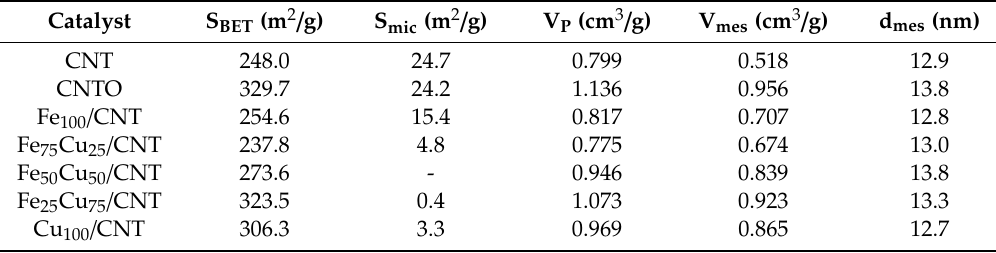
Table 3. Textural properties of CNT, CNTO and Fe 100 − x Cu x / CNT samples.